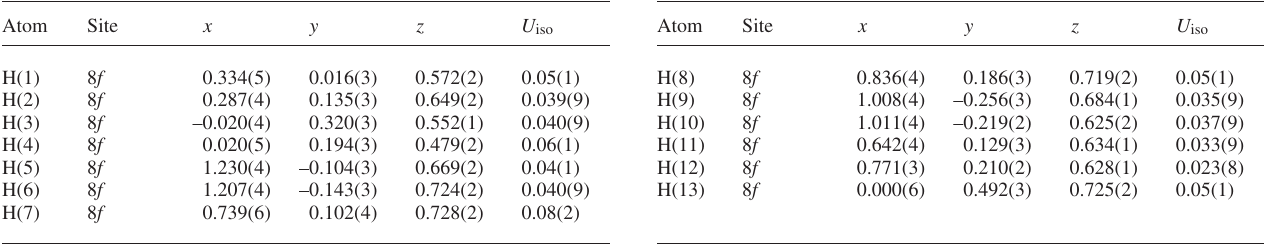
Table 2. Atomic coordinates and displacement parameters (in Å 2 )